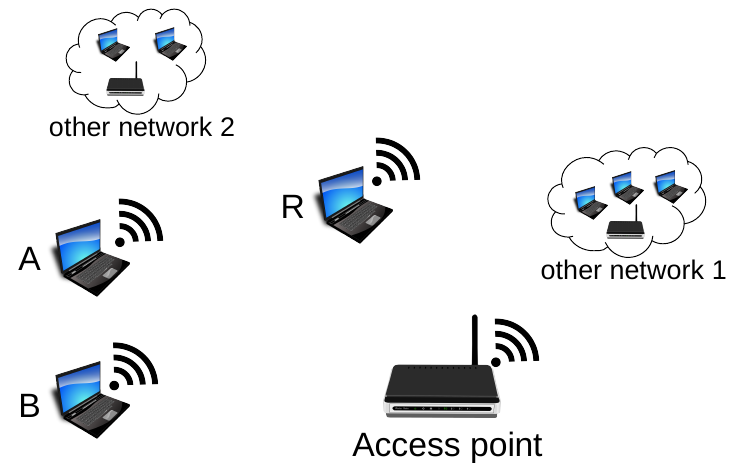
Figure 8. The stations used for the experiments in Both-informed variant (A and B—stations trans- mitting covert information; R—covert information